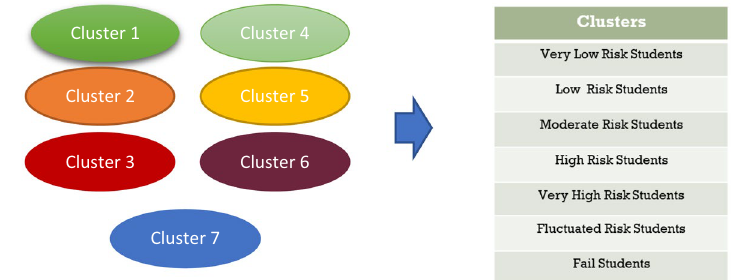
Fig. 11 Labelling of clusters in